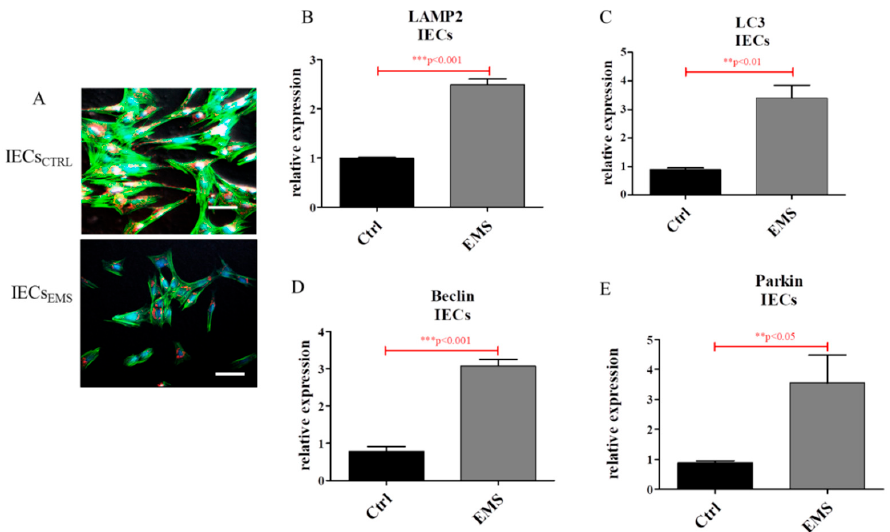
Figure 6. Autophagy in IECs CTRL and IECs EMS . Mitochondria condition and autophagy in IECs. Using confocal microscopy, co-localization of LAMP2 and mitochondria was visualized in investigated cultures ( A ). Representative photographs indicate increased lysosome and mitolysosome formation in EMS groups. Moreover, RT-PCR analysis revealed increased expression of auto/mitophagy related genes including LAMP2 ( B ), LC3 ( C ), Beclin ( D ) and Parkin ( E ). Scale bars: confocal microscope: 20 µm. Results expressed as mean ± S.D. ** p < 0.01, *** p < 0.001.